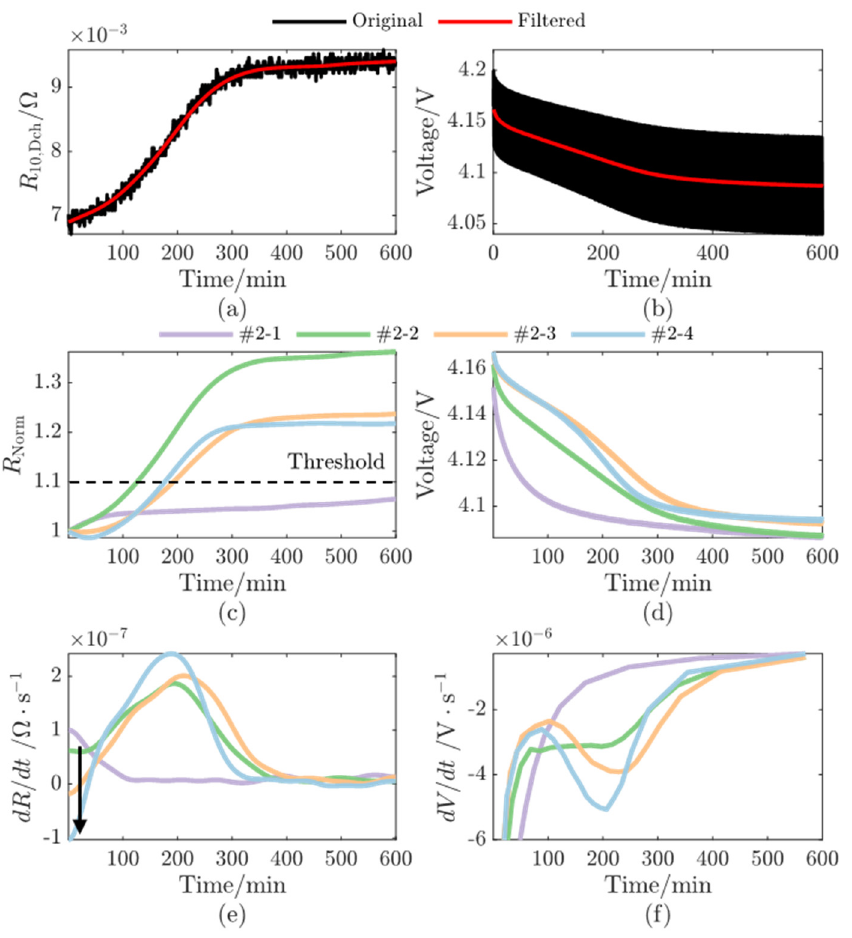
Figure 7. The internal resistance and voltage result. ( a ) Original and filtered internal resistance curve of experiment #2-2; ( b ) Original and filter voltage curve of experiment #2-2; ( c ) Normalized internal resistance R Norm curves; ( d ) Relaxation voltage curves; ( e ) dR/dt curves; ( f ) dV/dt curves.